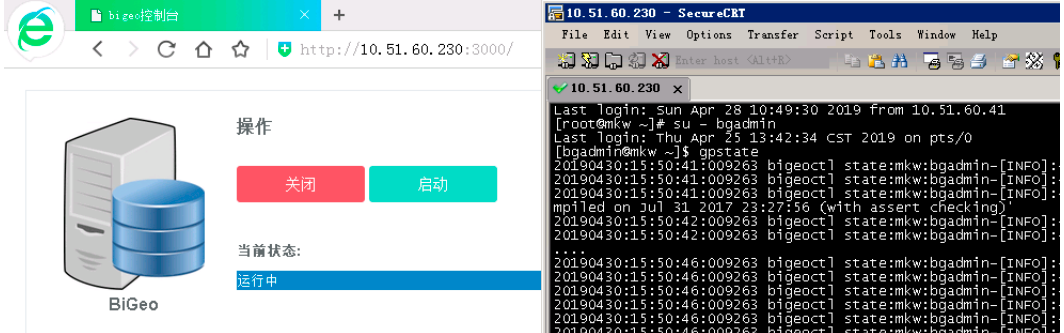
Figure 3. Data cluster management. Through the WEB interface, we can remotely start and stop the data cluster and monitor the status of the data nodes. With shell tools, we can also use the full GP tool for cluster maintenance.